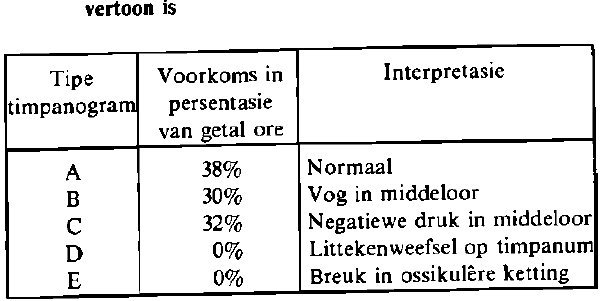
Tabel 6: Timpanometriese resultate wat deur die